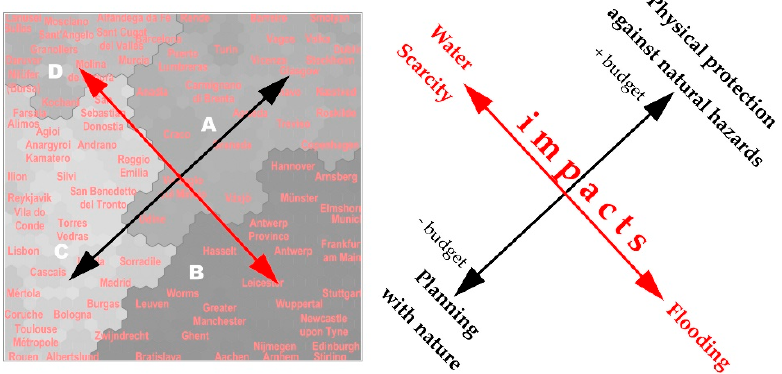
Figure 11. Synthetic scheme of the patterns observed in the map of municipal strategies created by means of the SOM methodology. Source: Compiled by the authors.